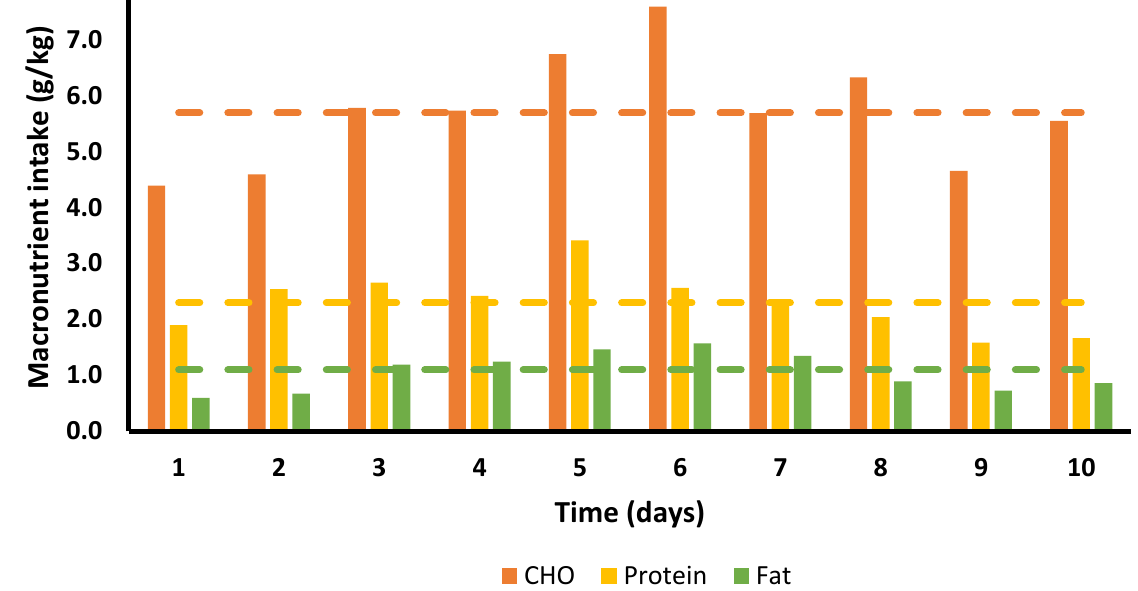
Figure 2. Daily macronutrient intake in grams per kg body mass. Bars represent individual macronutrient intake per day; dashed lines correspond to mean intake for each macronutrient.